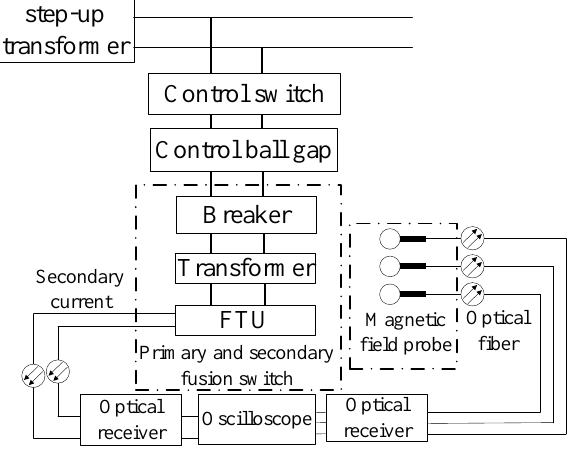
Figure 4. Test wiring diagram.